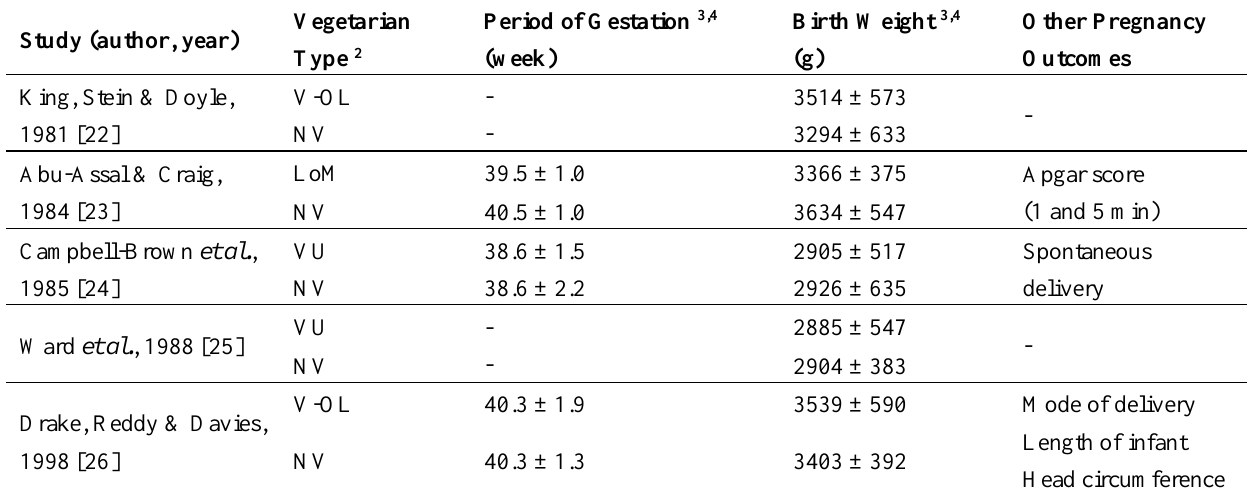
Table 3. Functional outcomes of pregnancy assessed in included studies 1